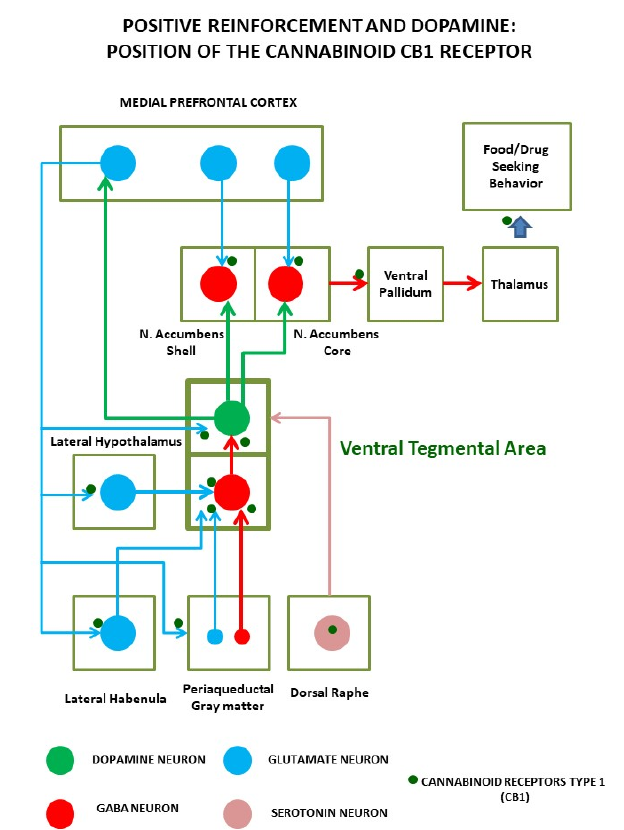
Figure 1. Positive reinforcement induced by palatable foods (and abused drugs) relies on the activation of a complex circuit around the dopaminergic neurons of the ventral tegmental area. These neurons not only detect ongoing reinforcements but code anticipation of future access to them. Dopamine cells are sensitive to multiple inputs, including hormones and nutrients, and are regulated by cortical, subcortical, and brainstem projections, mainly from gamma-aminobutyric acid (GABA) and glutamate cells. Precisely, in the axon terminals of these neuronal inputs, cannabinoid receptors regulate neural transmission and plasticity events that lead the transition from controlled intake to the compulsive intake that characterizes addiction.